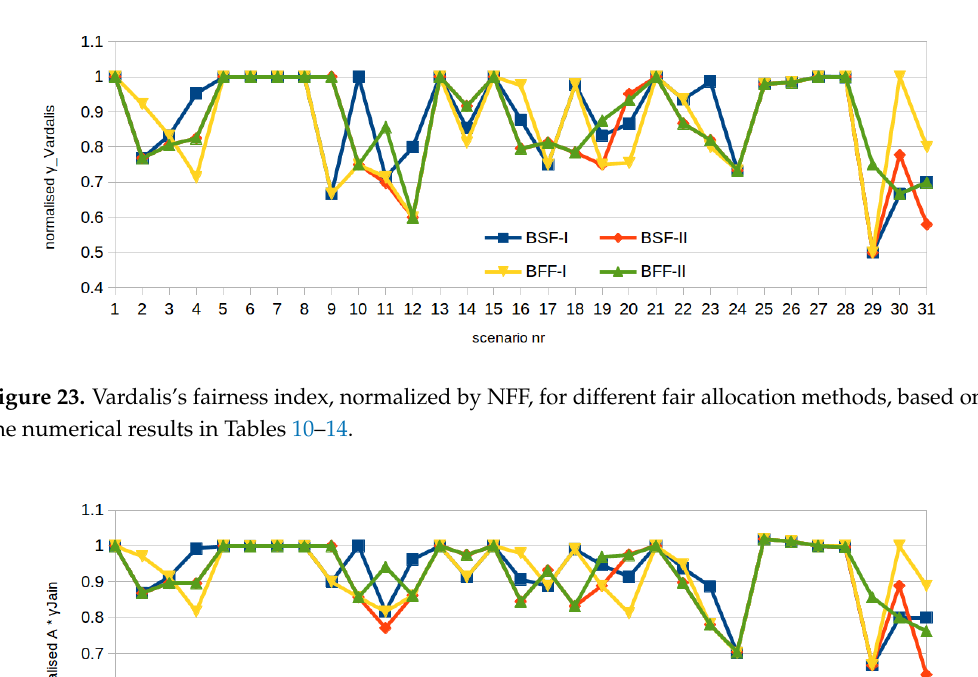
Figure 22. Jain’s fairness index, normalized by NFF, for different fair allocation methods, based on the numerical results in Tables 10–14.